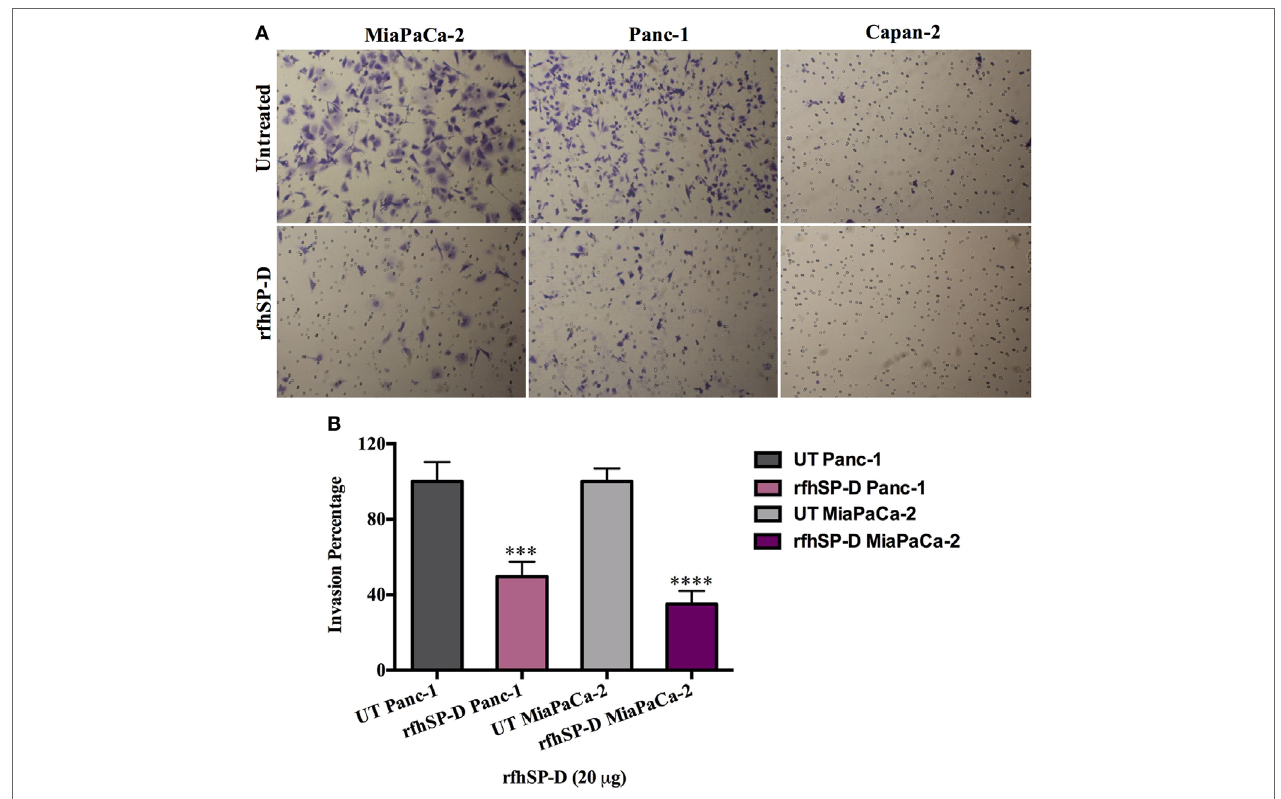
FigUre 4 | Recombinant fragment of human SP-D (rfhSP-D) supresses invasiveness in pancreatic cancer cell lines. (a) The cell invasion was analyzed by incubating 35,000 cells with and without rfhSP-D (20 µg/ml) in the BioCoat ™ Matrigel ™ Invasion Chambers at 37°C for 22 h. The invasive cells were fixed and stained before mounting the membrane on the slide for cell counting. The images show the difference between treated and untreated. (b) Treatment with rfhSP-D significantly reduced the cell invasion as for Panc-1 (~50%) and MiaPaCa-2 (~65%). However, as anticipated, no invasion was detected in Capan-2 cell line, neither in treated nor untreated samples. Significant values were considered based on *** p < 0.001 and **** p < 0.0001 between treated and untreated